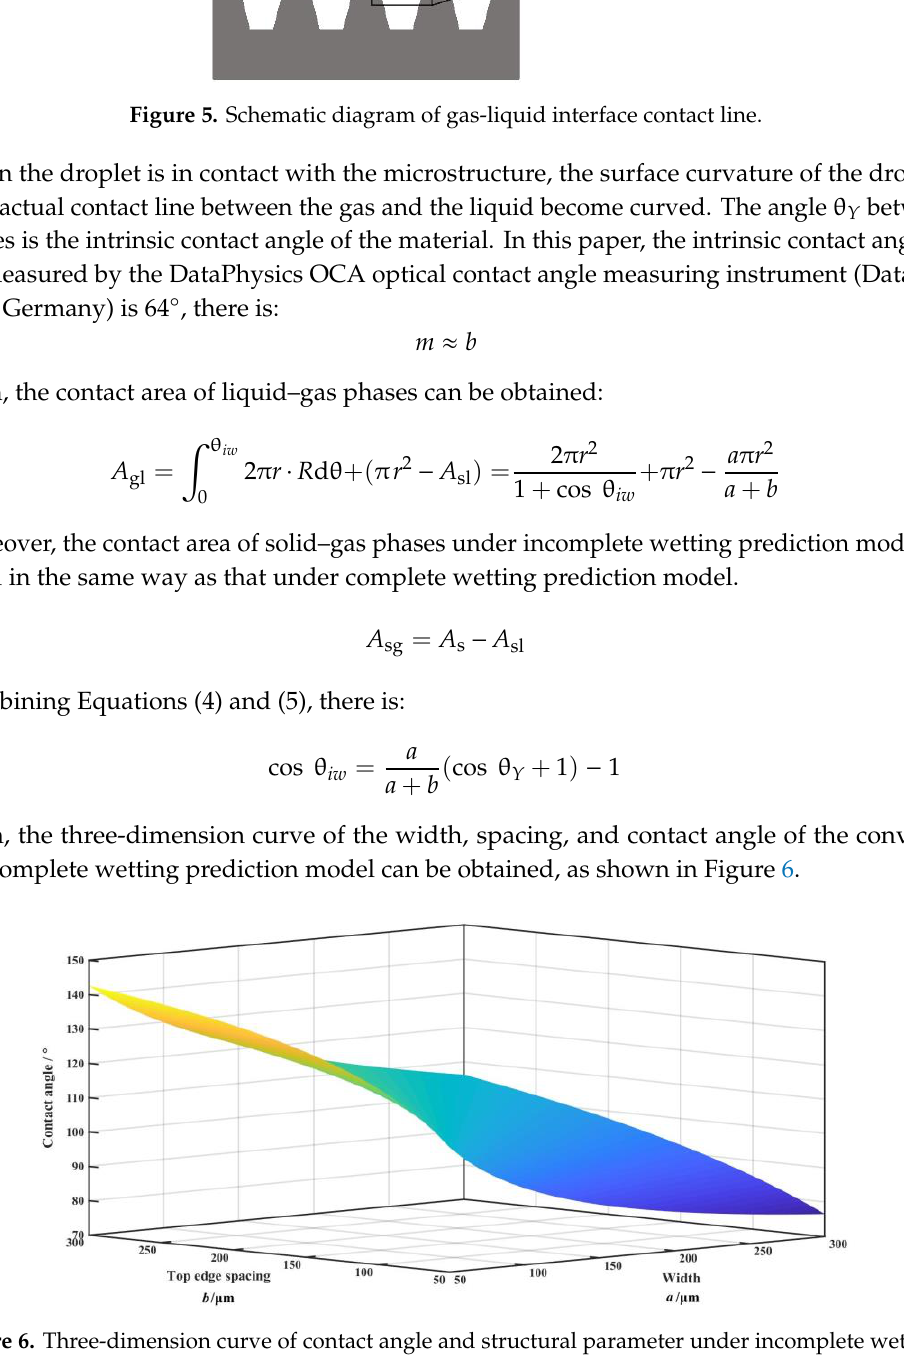
Figure 6. Three-dimension curve of contact angle and structural parameter under incomplete wetting prediction model.